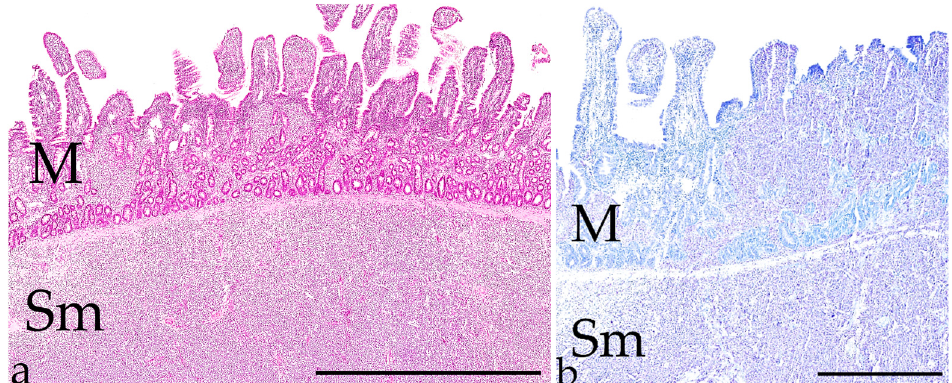
Figure 8. Intestinal MCT. ( a ) : Histology shows neoplastic infiltration of mast cells in the small intes- tinal mucosa (M) and submucosa (Sm) of a 13-year-old male castrated DSH; (HE stain, bar = 2 mm). ( b ) : Metachromatic staining of granules in neoplastic mast cells in the same tumour (Giemsa stain, bar = 600 µm).